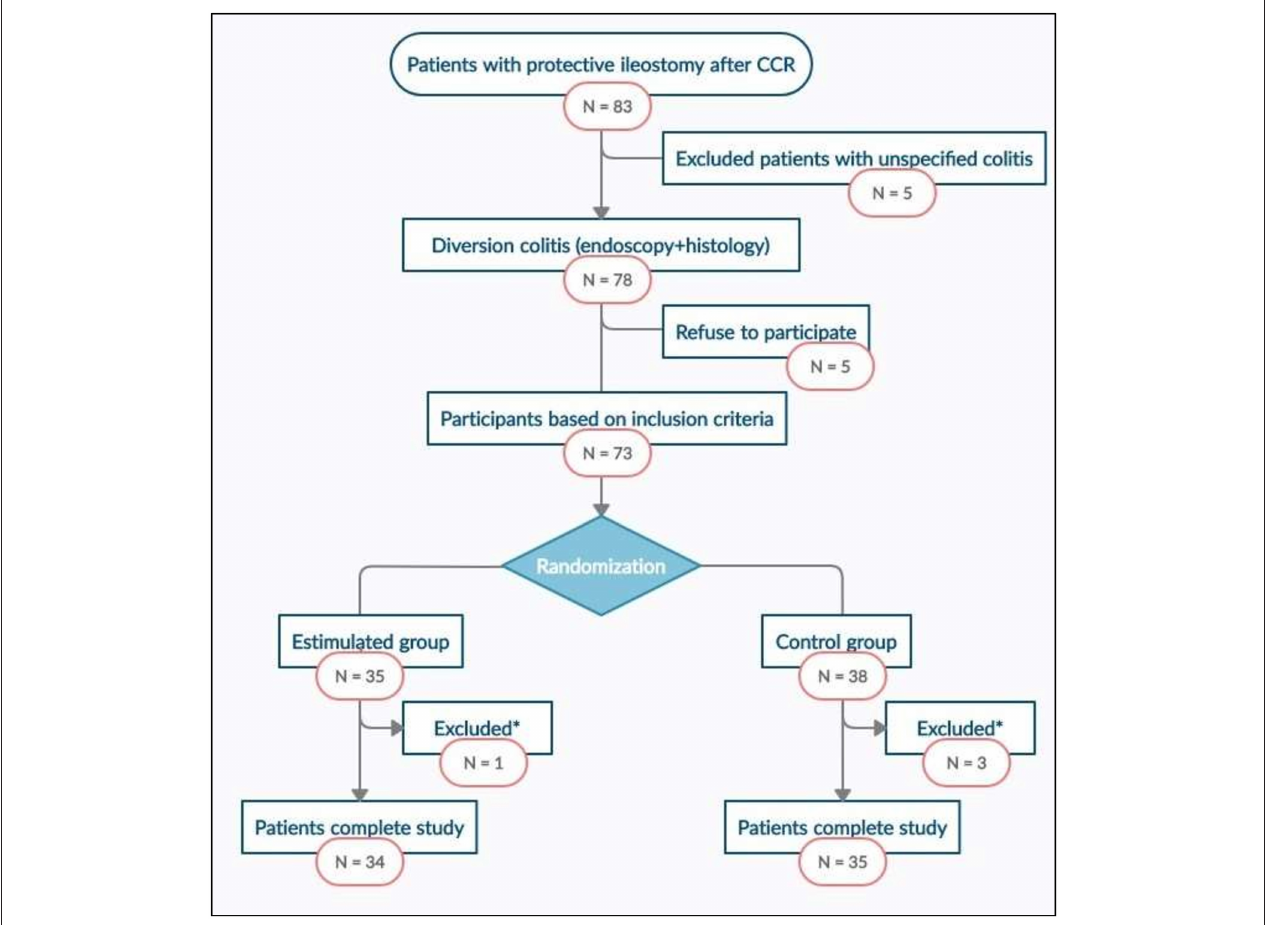
FIGURE 1 | Study flowchart. CRC, Colorrectal cancer. *Excluded patients with anastomic